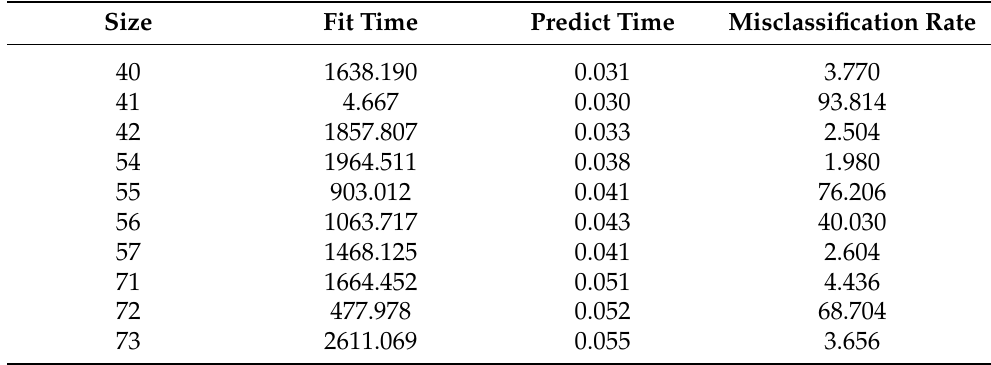
Table 3. Errors of fruit’s misclassification rates of single hidden layer ANN. The misclassification rate values are average values of 5 experiments. The columns are hidden layer network size, relative time to fit, relative time to predict and misclassification rate in percent. Relative time is the time in comparison with NN with Euclidean